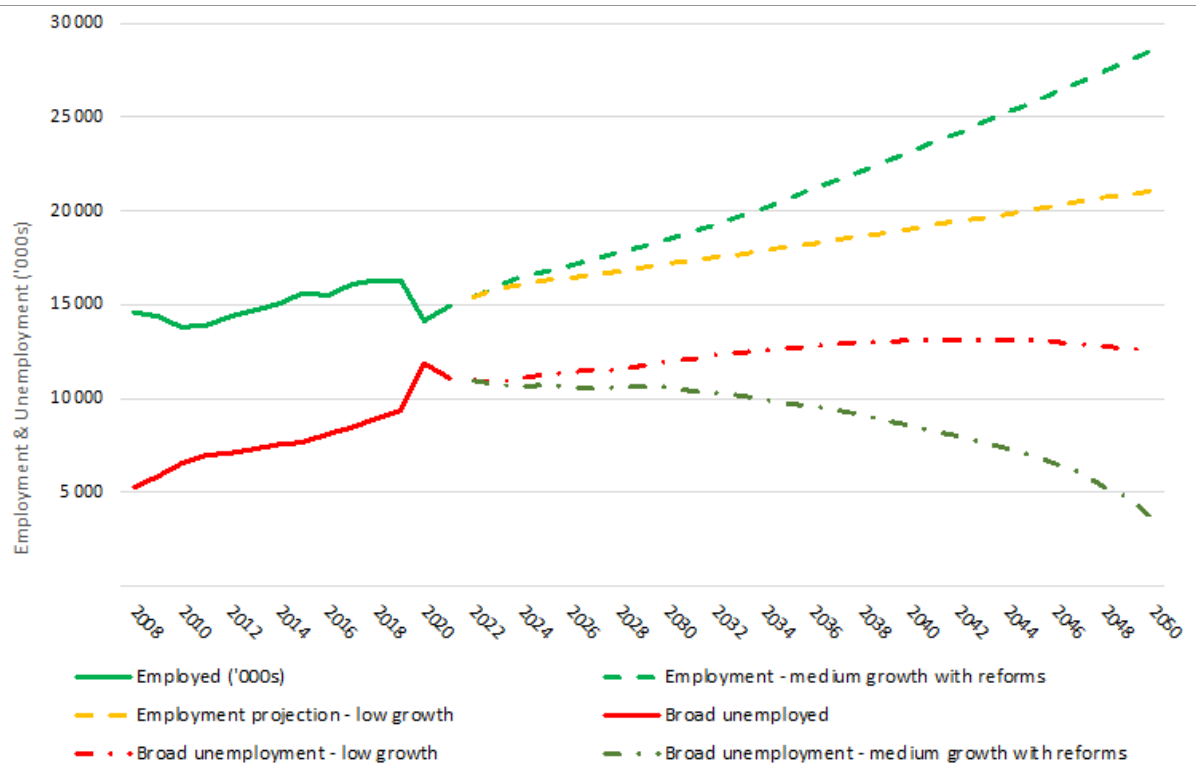
Figure 3: Employment and unemployment – past, present and